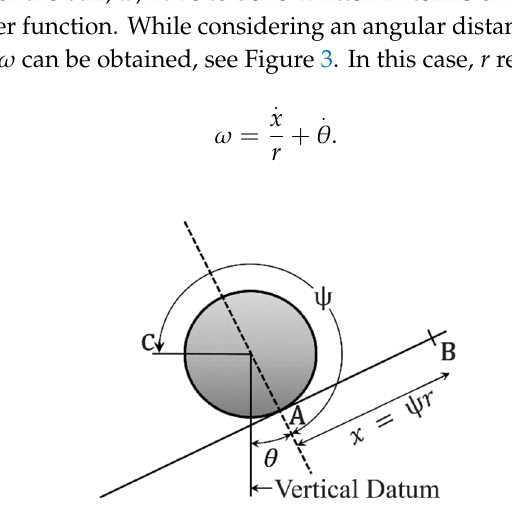
Figure 3. Angular velocity definition of the ball.